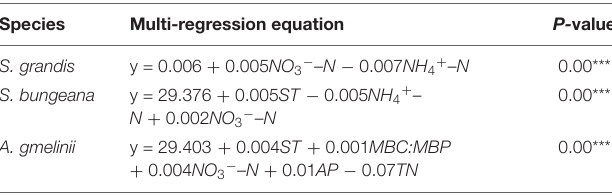
TABLE 2 | Multiple regression equation between WUE and soil properties and microbial biomass ecological stoichiometry characteristics. Species Multi-regression